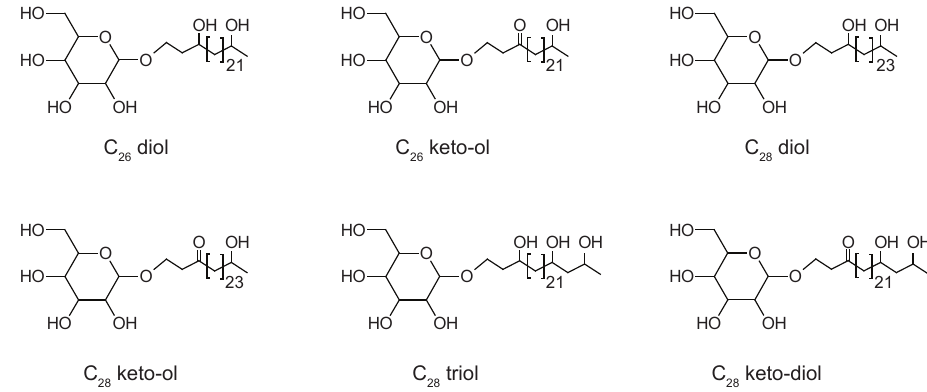
Figure 1. Structures of the C 6 heterocyst glycolipids (HG) targeted by the study. C 26 diol HG (1-(O-hexose)-3,25-hexacosanediol); C 26 keto- ol HG (1-(O-hexose)-3-keto-25-hexacosanol); C 28 diol HG (1-(O-hexose)-3,27-octacosanediol); C 28 keto-ol HG (1-(O-hexose)-3-keto-27- octacosanol); C 28 triol HG (1-(O-hexose)-3,25,27-octacosanetriol); C 28 keto-diol HG (1-(O-hexose)-27-keto-3,25-octacosanediol).